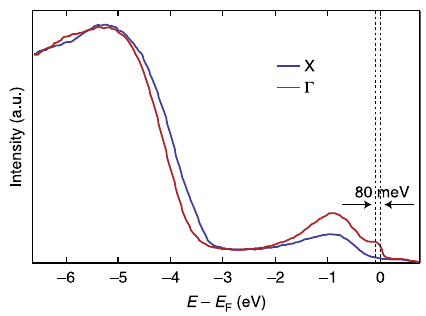
Fig. 2 ARPES energy distribution curves. Energy distribution curves at the X ( blue curve ) and Γ ( red curve ) points of the BZ for a crystal at 20 K doped with an excess electron density n = 2 × 10 19 cm − 3 . The spectra exhibit a feature at − 1 eV, corresponding to the in-gap oxygen defect states. The curve at Γ exhibits spectral weight at E F , which lies 80 meV above the conduction quasiparticle band. The spectrum is referenced to E F